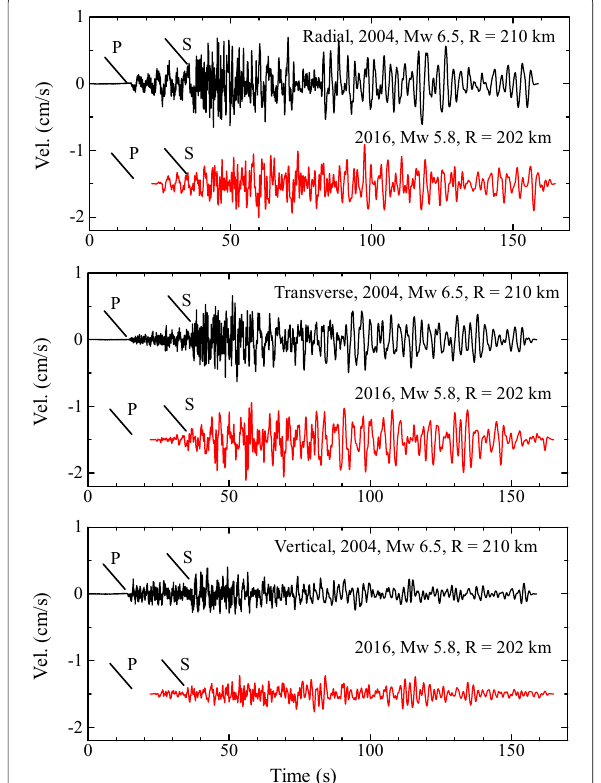
Fig. 3 Plot of radial (upper panel), transverse (middle panel), and vertical (lower panel) component acceleration time histories recorded at site AIC004 (see Fig. 1 for location) for the 2004 (upper trace in each panel) and 2016 (lower trace in each panel) events. The recordings are aligned to match the S-wave arrivals. The arrivals of P- and S-waves are indicated by the letters P and S, respectively. The hypocentral distance (R) is rounded to the nearest whole number.